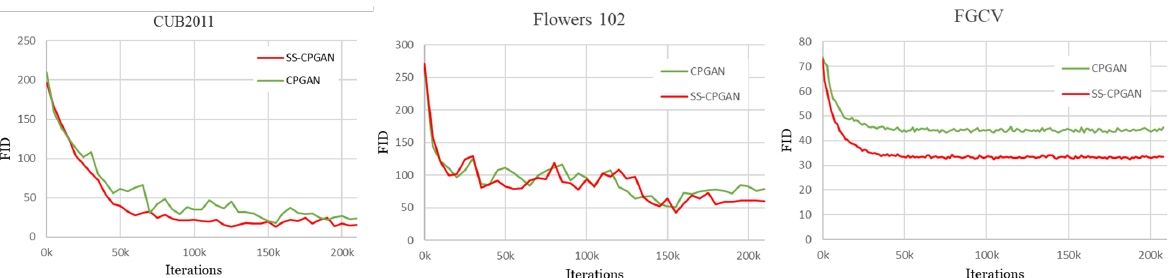
Figure 3. FID training curves for CPGAN and SS-CPGAN on the datasets: CUB2011, Flowers 102, and